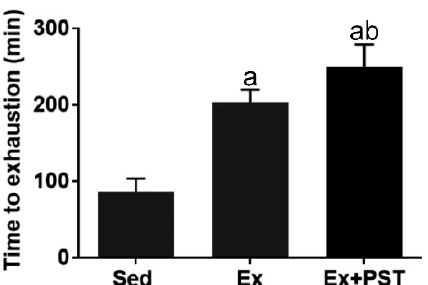
Figure 1. Effect of pterostilbene (PST) supplementation on endurance capacity in exercise training rats. After the run-to-fatigue experiments, time to exhaustion (TTE) was recorded. Data are expressed as mean ± SD, a— p < 0.05 compared with Sed group; b— p < 0.05 compared with Ex group.